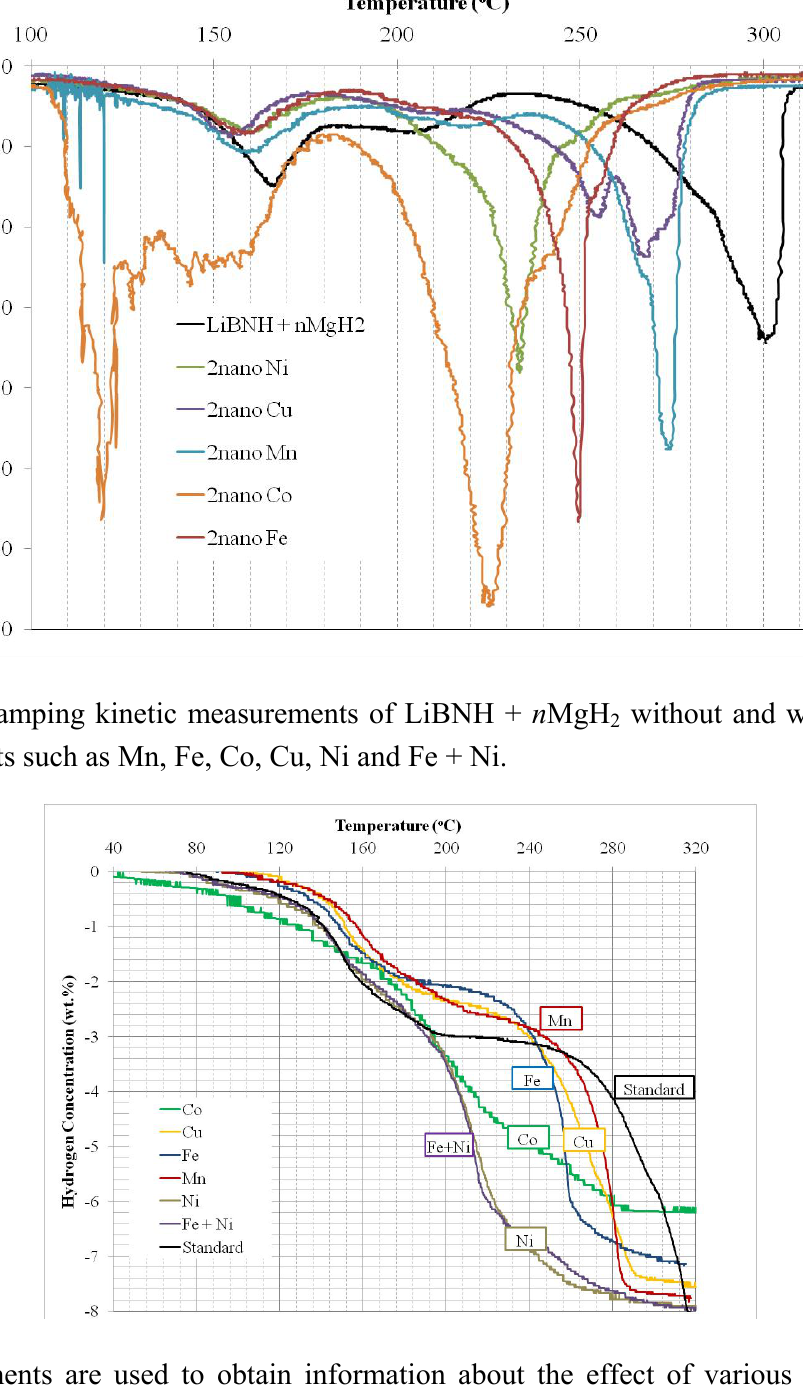
Figure 3. TPD profiles comparison of LiBNH + n MgH nano catalysts such as Ni, Cu, Mn, Co and Fe at a constant ramping rate of 1 °C/min.